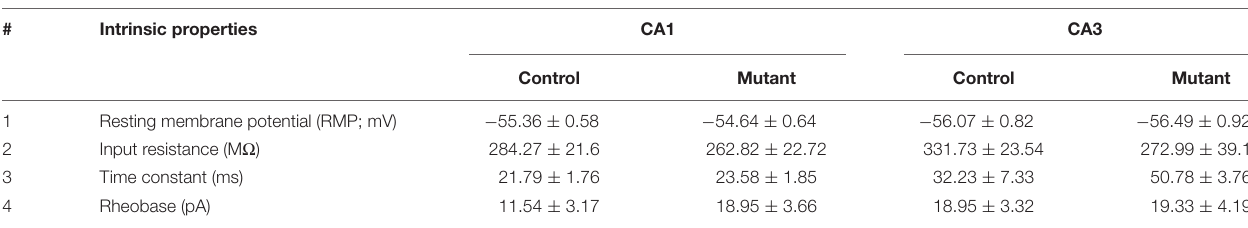
TABLE 1 | Summary table of intrinsic membrane